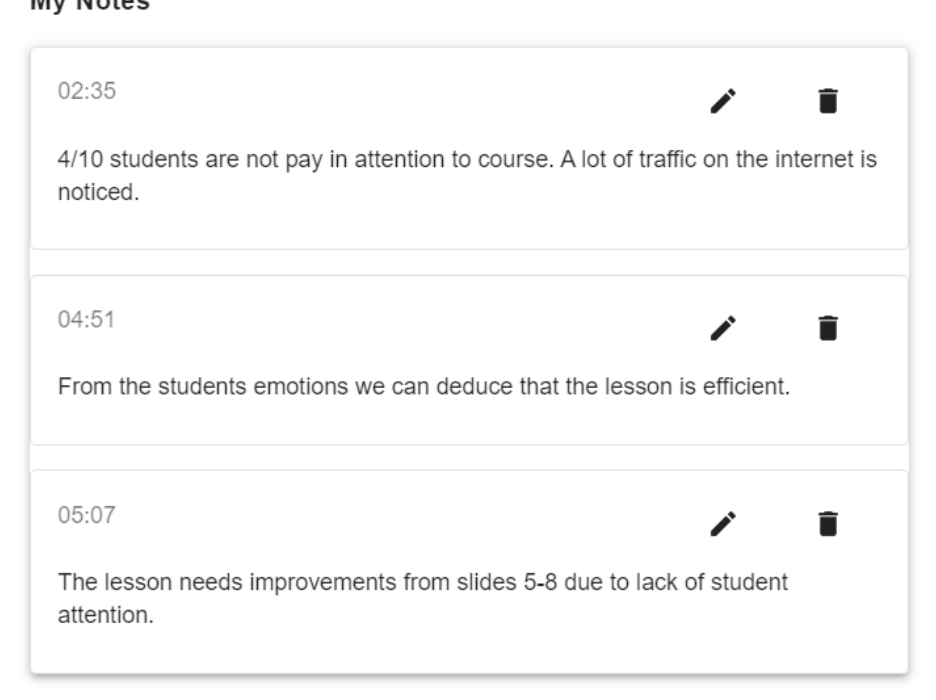
Figure 12. Available Notes Modal.